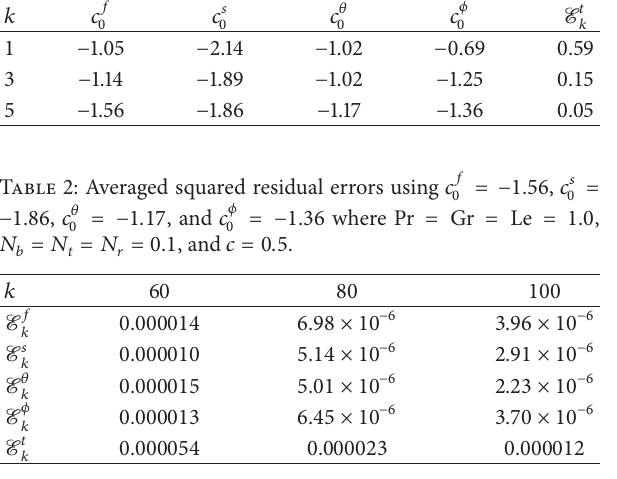
Table 1: Global optimal convergence control parameters at different orders of approximations for Pr = Gr = Le = 1.0 , 𝑁 𝑏 = 𝑁 𝑡 = 𝑁 𝑟 = 0.1